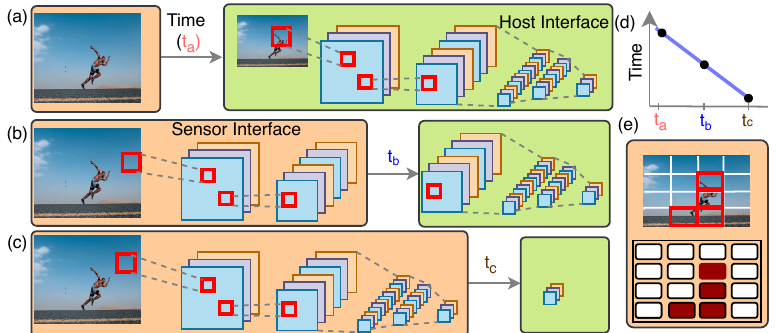
Figure 1. ( a ) Conventional image processing. Sensor is a passive device and continuously sends image to the server or host for processing ( b ) Sensor and host collaborative computation. The vision task is divided between the sensor and host platform ( c ) Full computation on the edge and the sensor becomes active device ( d ) Data propagation delay in these three steps ( e ) Our approach of attention-oriented relevant information processing at the sensor.